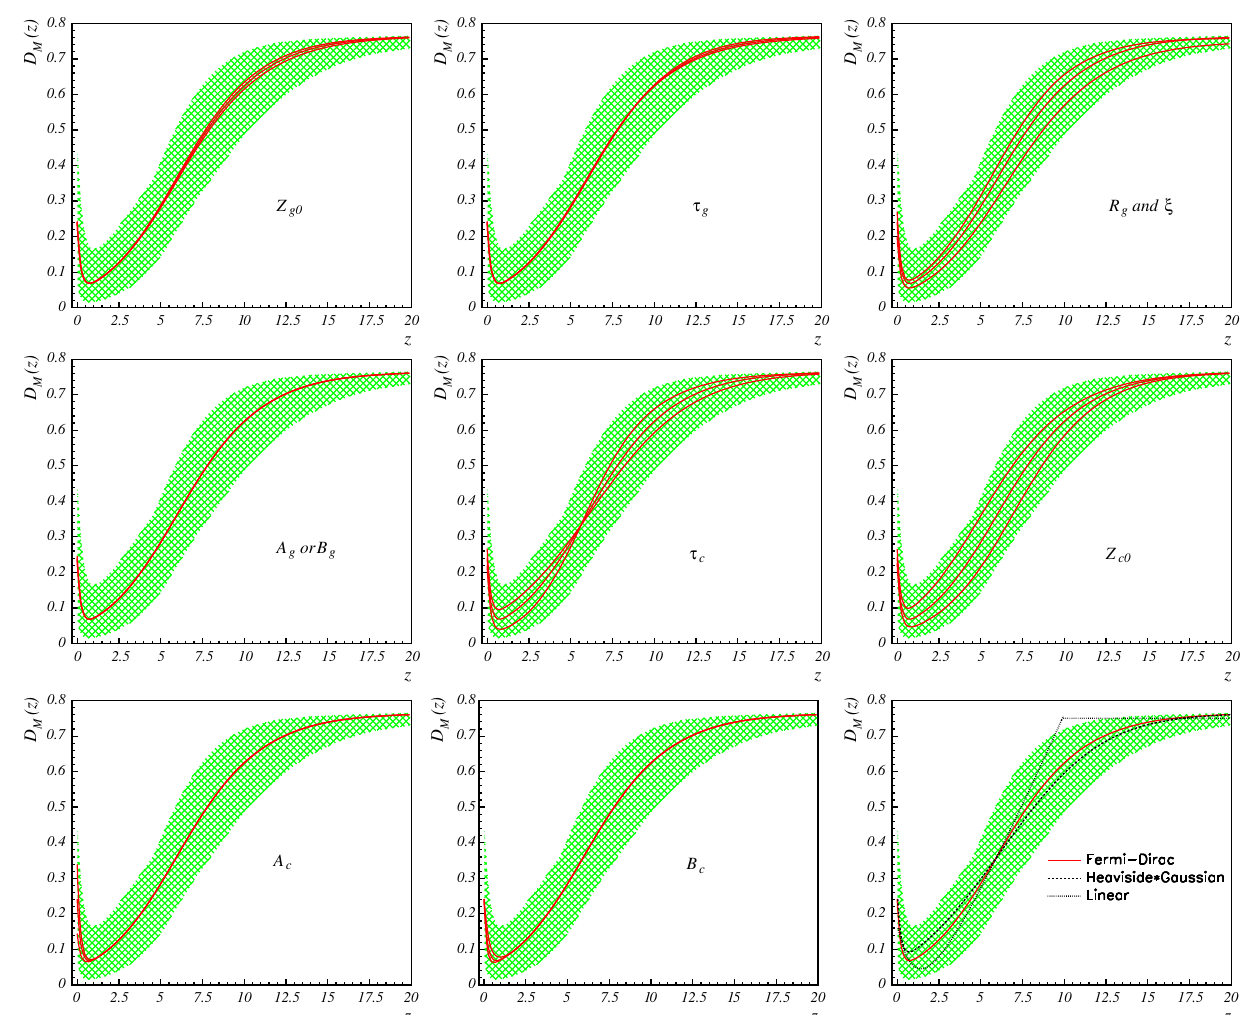
Fig. 2 Individual and total contributions of the parameter uncertain- ties to the depletion factor D M ( z ) . The central line shows D M ( z ) for the nominal values of the parameters. The two other lines (sometimes masked by the central line) correspond to upper and lower values of the parameter labelled in the panel, the other parameters being kept at their